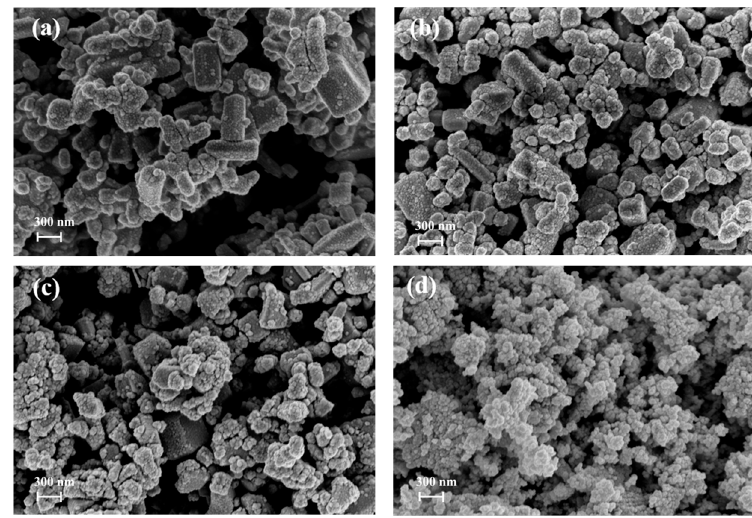
Figure 9. SEM images of CuS/PbS/ZnO photocatalysts prepared at different hydrothermal temper- atures. ( a ) 100 ° C , ( b ) 130 ° C , ( c ) 150 ° C , and ( d ) 170 ° C . Table 4. BET surface area, pore volume, and pore size of CuS/PbS/ZnO. Photocatalyst